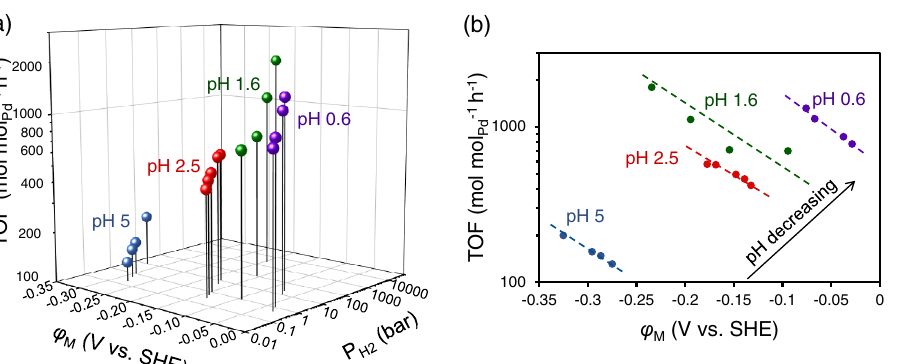
potential at pH 1.6 on Pd/C (5wt.%) at 298K. b The corresponding projection onto at OCP under pH is used for pH 1.6 that is equilibrated the plane of TOF vs. φ M . A hypothetical P H 2 2 with the externally added electric